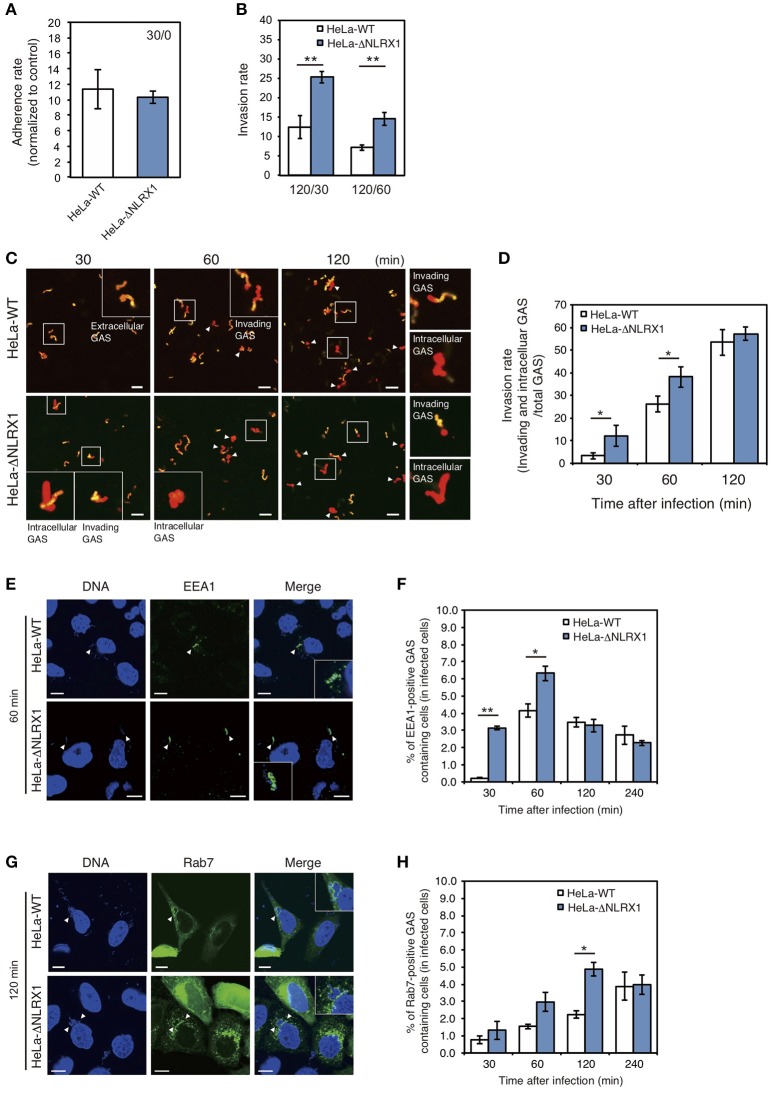
NLRX1 inhibits endocytosis-mediated Group A Streptococcus (GAS) invasion. (A,B) Adherence (A) and invasion (B) rates of GAS. HeLa wild-type and NLRX1 KO cells were infected with GAS (MOI = 100). After 30 or 60 min of infection, cells were washed with PBS and further incubated for 60 min with DMEM/10% FCS with gentamicin (100 μg/mL) to kill extracellular bacteria. Cells were disrupted with distilled water and serial dilutions of cellular extracts were plated on THY agar plates; colony counting was then performed. The data presents the invasion rate as the ratio of total intracellular GAS 120 min after infection to total adherent GAS at 30 or 60 min after infection. Data are representative of ≥ three independent experiments. **P < 0.01. (C) Representative immunofluorescence image used for quantification of GAS invasion in (D). Extracellular/cell-associated GAS (orange) and intracellular GAS (red) were differentiated by staining with different Alexa-Fluor-conjugated GAS antibodies. GAS stained both orange and red were scored as invading bacteria (white arrow). (D) Quantification of GAS invasion into NLRX1 KO cells. Data were obtained by scoring at least 300 bacteria chains. Data are representative of ≥ three independent experiments. *P < 0.05. (E,G) Confocal microscopic images of EEA1 (E)- or Rab7 (G)-positive compartments containing GAS in HeLa wild-type and NLRX1 KO cells. Cells were transfected with EmGFP-Rab7, or immunostained with an anti-EEA1 antibody to visualize each endosomal marker. Cellular and bacterial DNA was stained with DAPI (blue). White arrowheads show EEA1- or Rab7-positive compartments containing GAS. Scale bars, 10 μm. (F,H) The number of cells containing EEA1- or Rab7-positive GAS was counted and presented as the percentage of the total number of GAS-infected cells. HeLa wild-type and NLRX1 KO cells were infected with GAS for indicated times. The data shown represent results from > 200 infected cells and include the mean value ± SD from three independent experiments. **P < 0.01, *P < 0.05.